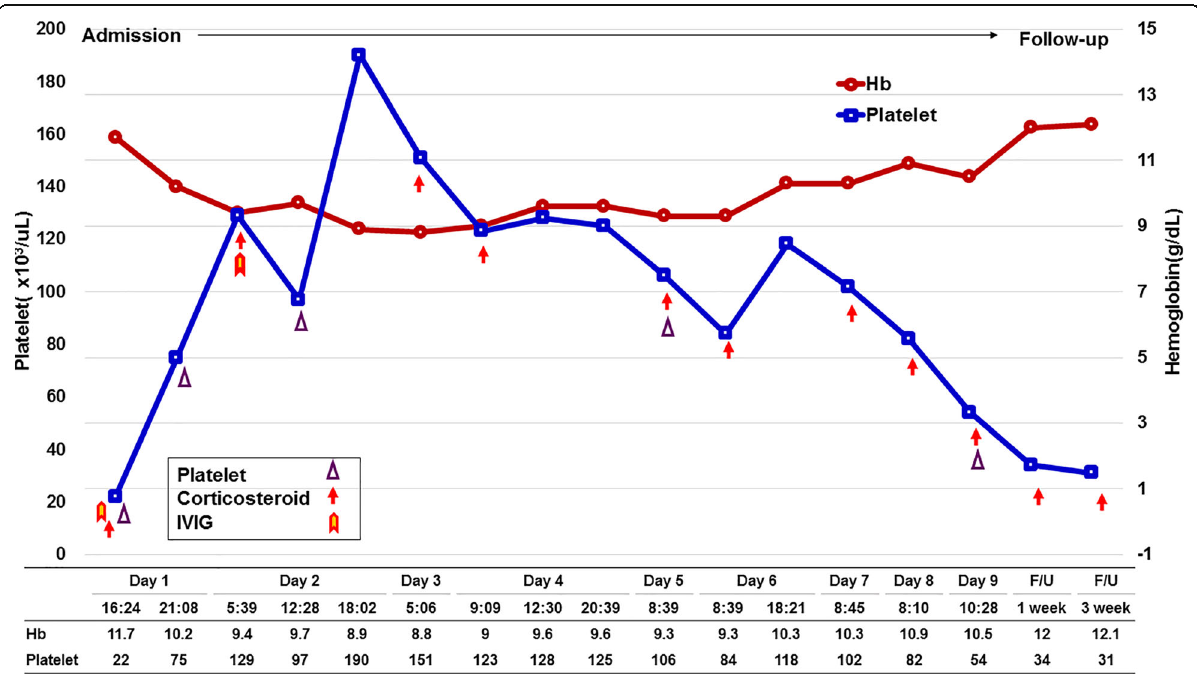
Fig. 3 Daily change of platelet count and hemoglobin. Platelet count (×10 3 /uL); Hb hemoglobin (g/dL); PLT (ml), platelet transfusion with platelet concentrate and plateletpheresis (ml); corticosteroid, (admission: solumedrol, mg, IV, discharge: solondo, mg); IVIG, intravenous immunoglobulin (IV-globulin SN, g,